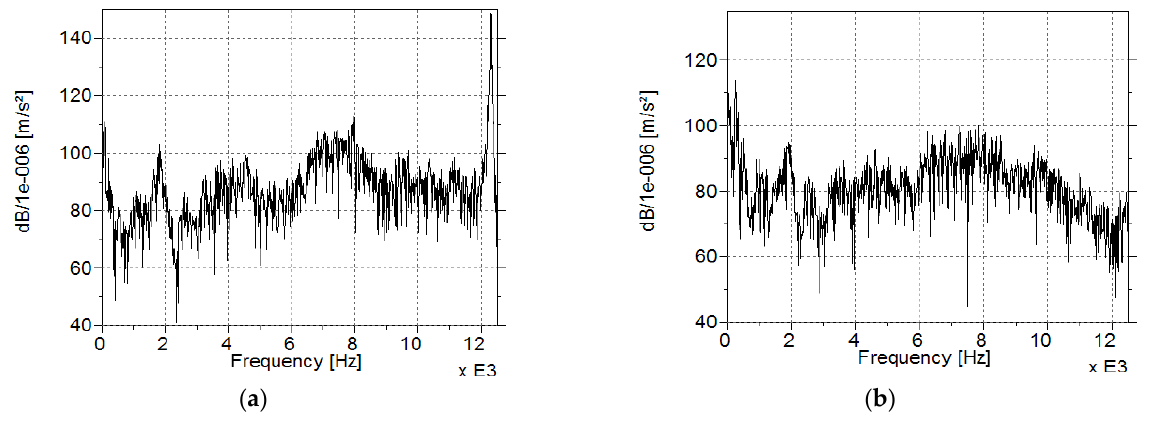
Figure 11. Configuration of chassis noise dynamometer test.